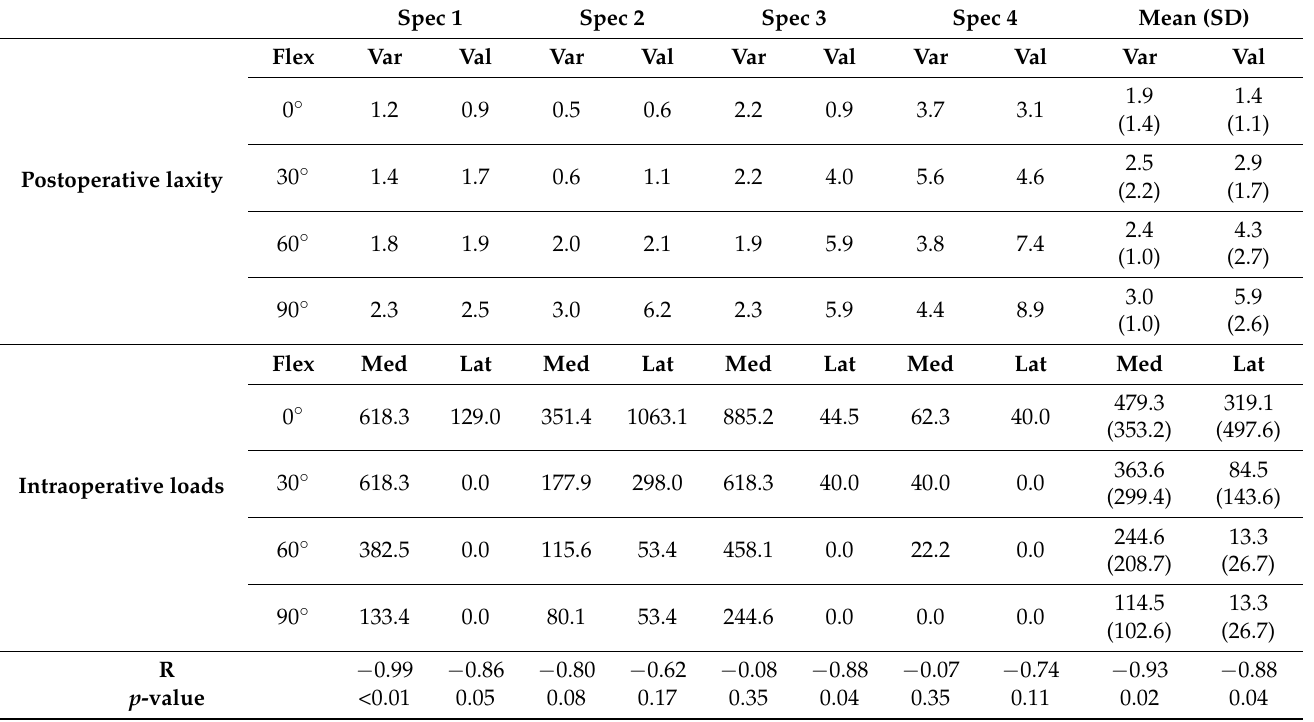
Table 1. Correlating the postoperative tibial abduction measured during the varus (Var) and valgus (Val) stress tests with the intraoperative intra-articular loads in the medial (Med) and lateral (Lat) compartments, respectively, at fixed knee flexion angles (Flex) for each specimen and consolidated for the means across all specimen (Pearson’s correlation coefficient (R); statistical significance: p <